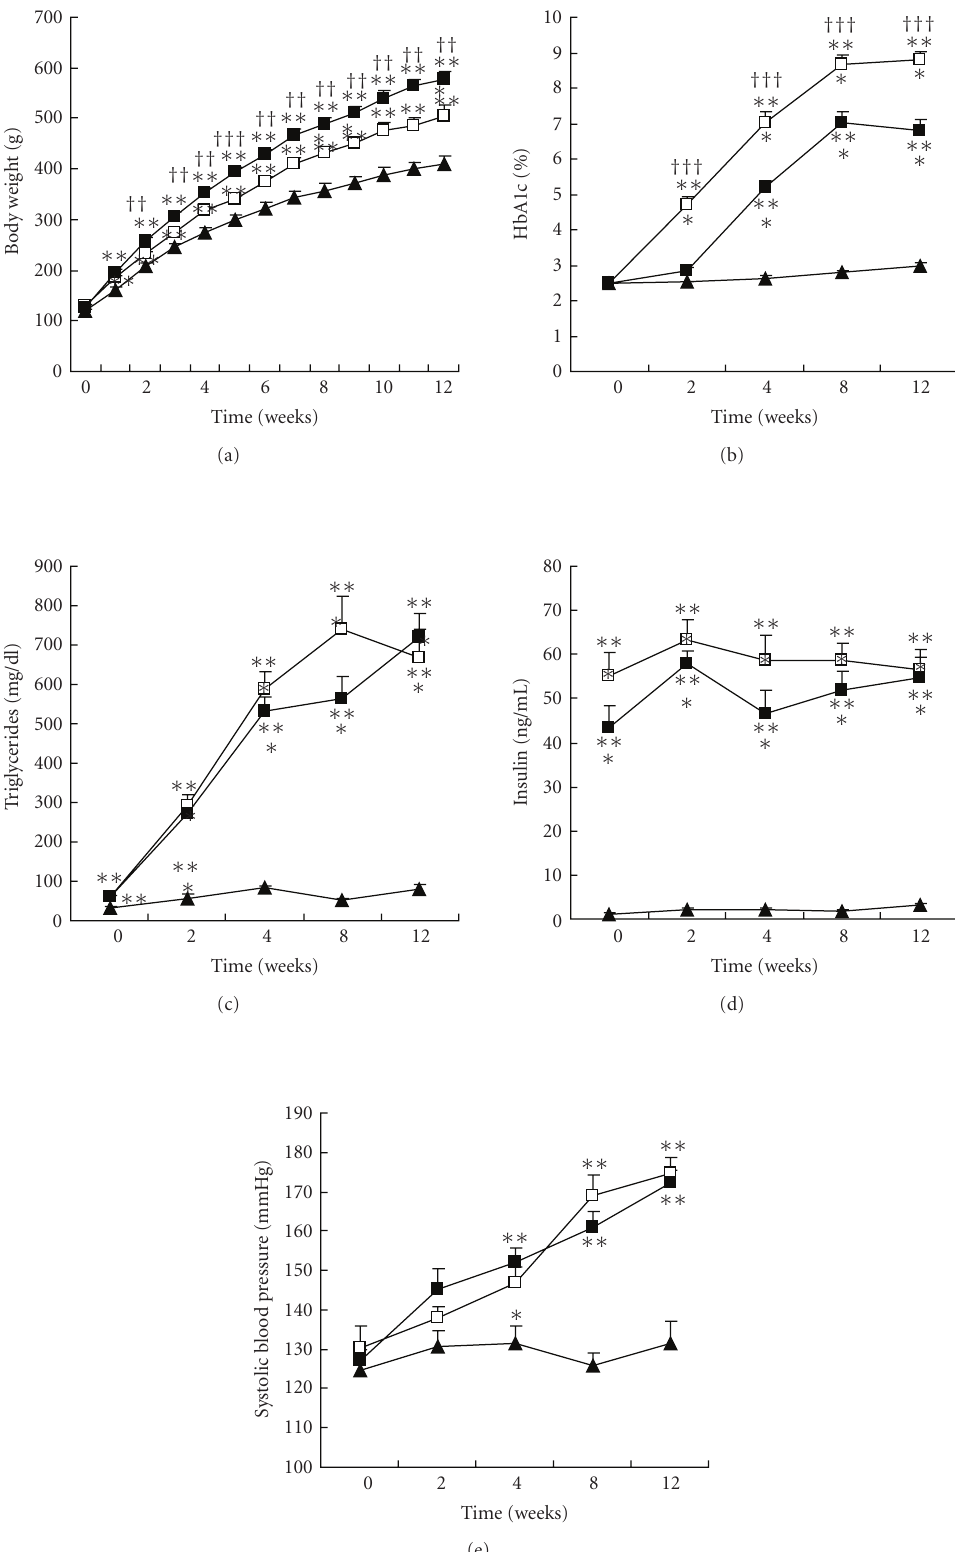
Figure 2: Metabolic abnormalities. (a) Body weight, (b) HbA1c, (c) triglycerides, (d) insulin, and (d) systolic blood pressure. WKY (closed triangle), MC/MF (closed square), and HC/LF (open square). ∗ P < . 05, ∗∗ P < . 01, ∗∗∗ P < . 001 versus WKY; †† P < . 01, ††† P < . 001 versus